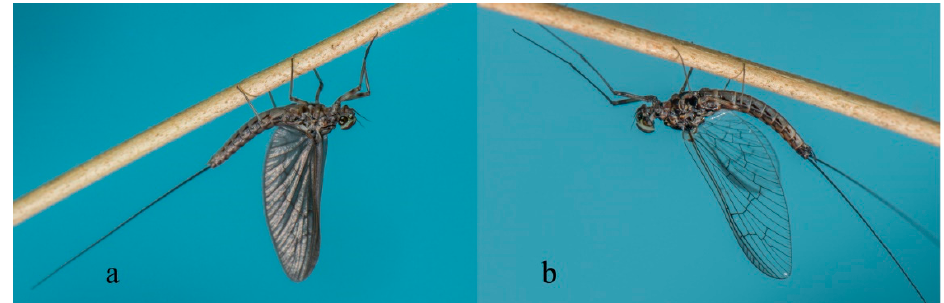
Figure 1. Cloeodes penai (Morihara & Edmunds) (Baetidae, Brazil) male subimago ( a ) and imago ( b ). Photograph courtesy of Frederico Salles.